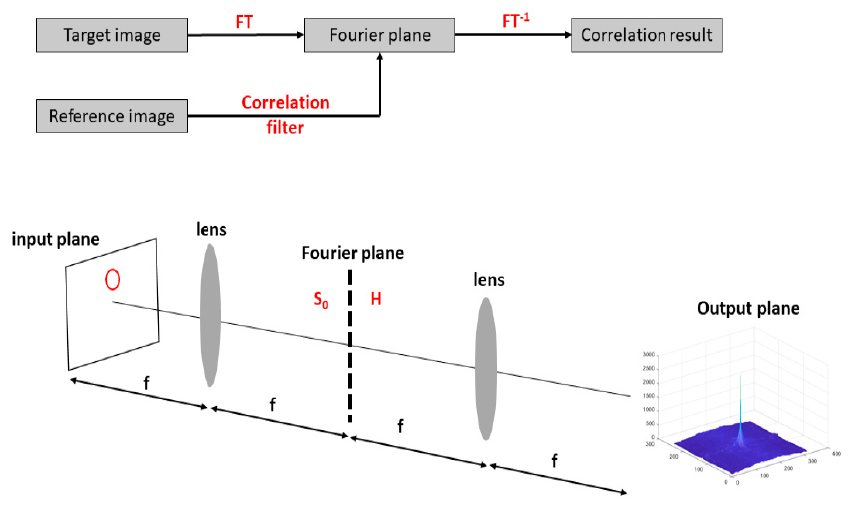
Figure 5. The structure diagram of the VLC optical correlator [6]. The circle in the input plane represents the face image. S 0 is a lens in the Fourier plane and H is a filter in the same